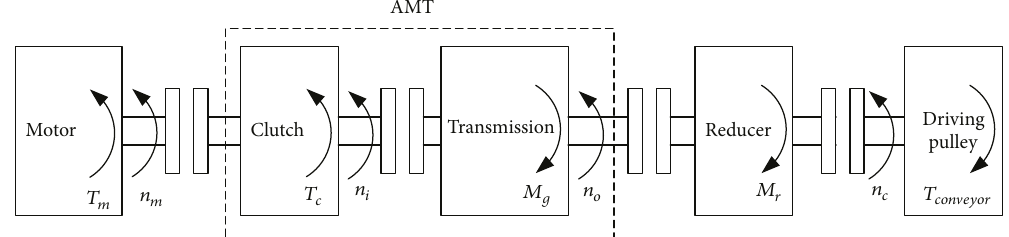
Figure 1: Drive line of AMT softly starting the belt conveyor.